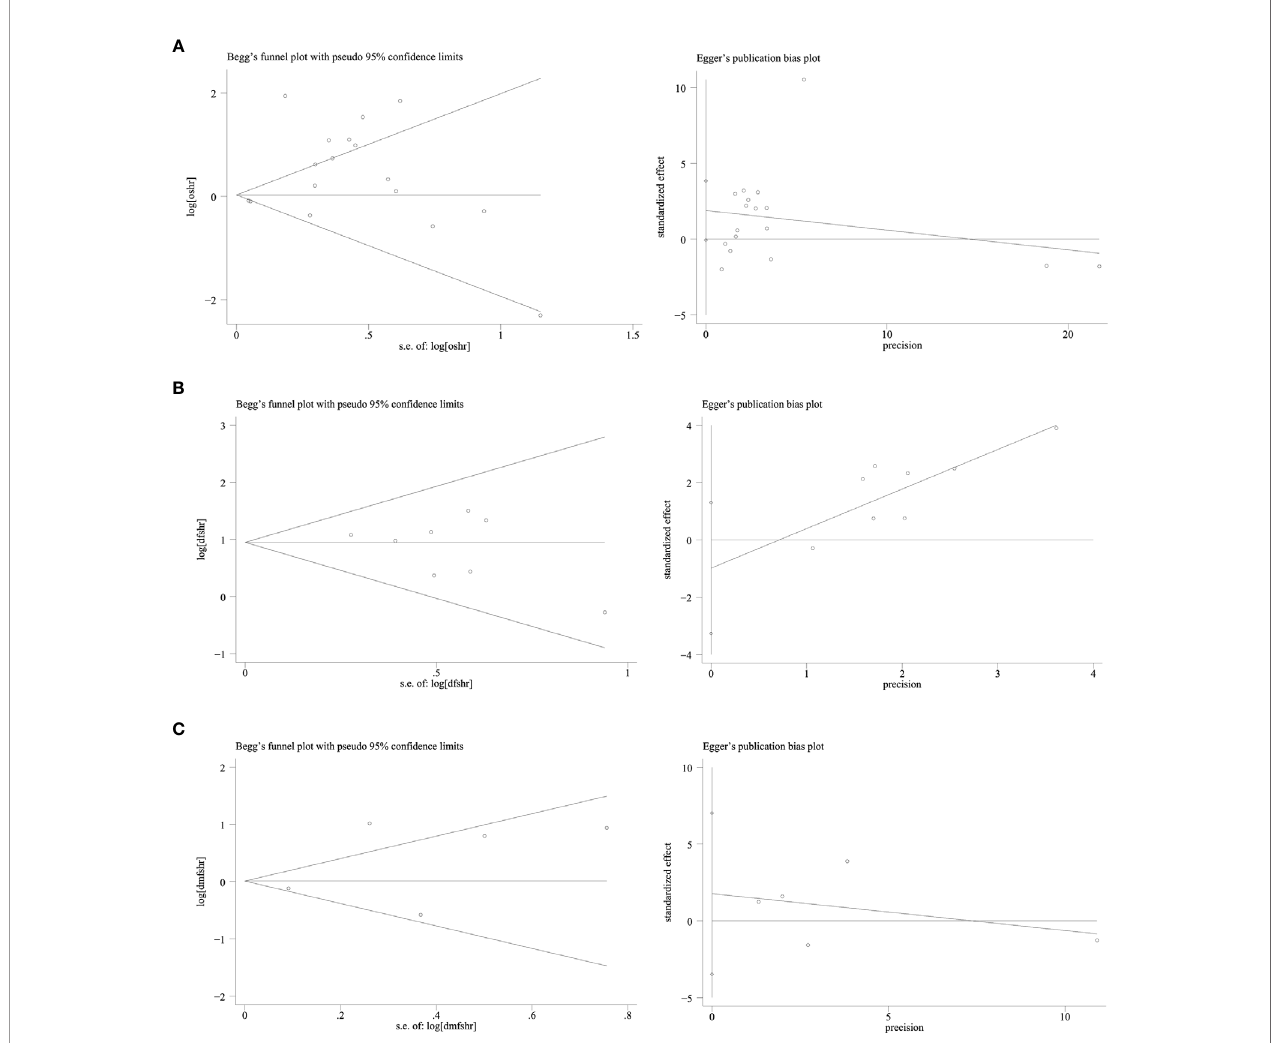
FIGURE 5 | Publication bias funnel plot of EGFR and OS, DFS, DMFS: Begg ’ s test and Egger ’ s test. (A) EGFR and OS. (B) EGFR and DFS. (C) EGFR and